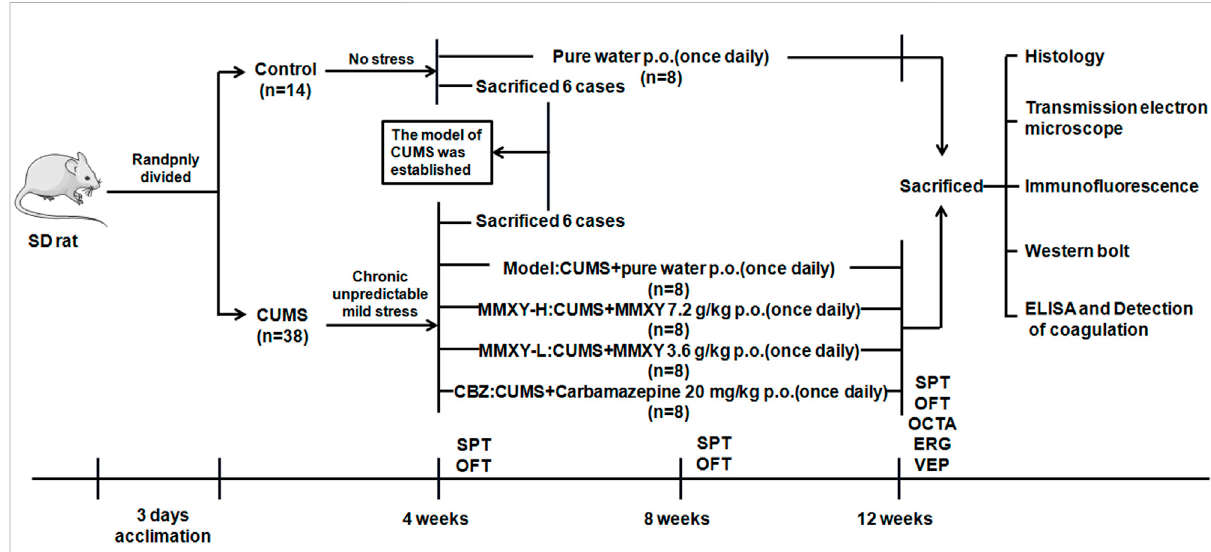
FIGURE 1 Experimental procedure of MMXY intervention study. The model was successfully established in week 4, and then CUMS group was randomly divided into Model group, MMXY-H group, MMXY-L and CBZ groups. Rats in each group were given drugs or distilled water lavage, once a day, until 12 weeks of death for sampling. SPT, sucrose preference test; OFT, open fi eld test; OCTA, optical coherence tomography angiography; ERG, electroretinogram; VEP, visual evoked